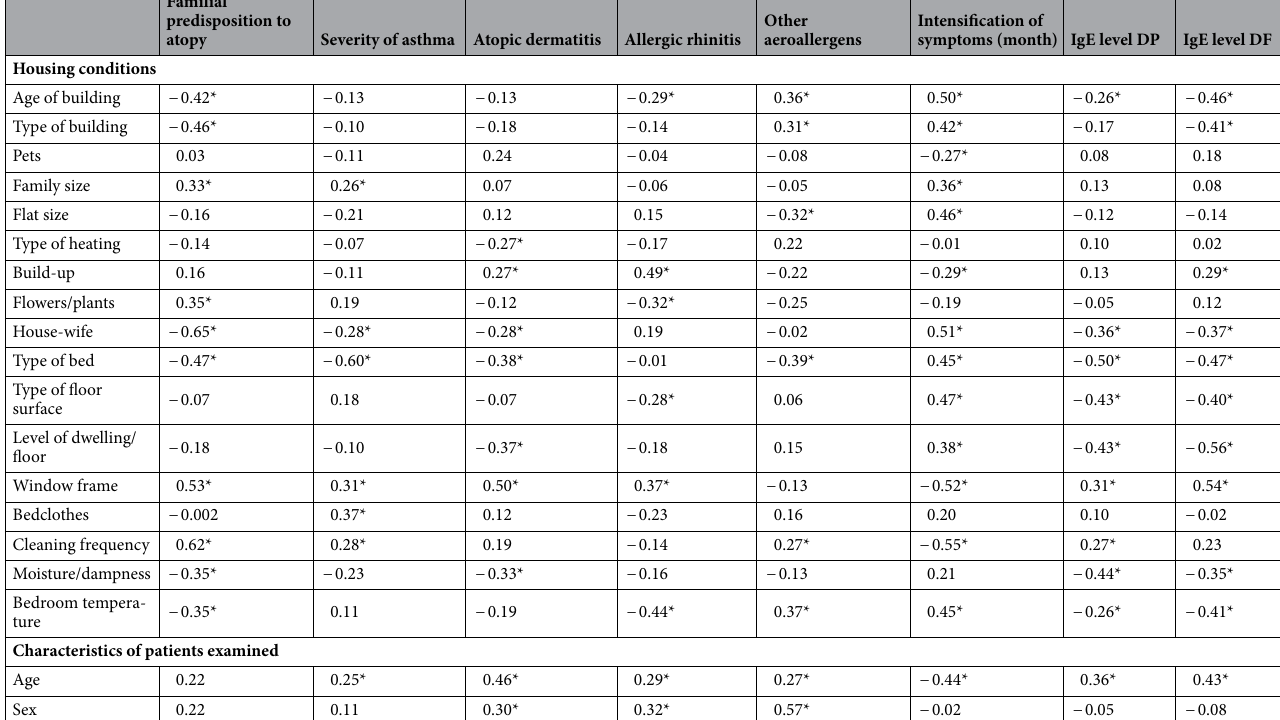
Table 7. Correlations observed between housing conditions, characteristics of patients and parameters of allergic disease in the examined patients in Bytom (south Poland). Results of the Spearman’s rank correlation test analysis (*p < 0.05). Age of building: in years; Type of building: block of houses [1], tenement-house [2], brick house (old) [3]; Pets: no pets [0], fish/reptilians [1], birds [2], mammals (cats, dogs, hamsters, rabbits) [3]; Family size: number of inhabitants; Flat size (area occupied by each flat): surface in square meters; Type of heating: central [1], electric [2] or coal-stove [3]; Build-up: compact [1], free standing [2];